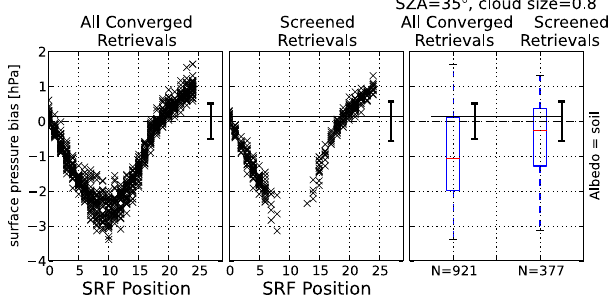
Figure 13. Summary of surface pressure and X retrieval bias CO 2 and covariance for all scenarios with 0.6 and 0.8 km clouds. Plot panels are arranged in the same order as Fig. 8. In each panel, the screened retrievals are shown (black points) along with the mean clear sky retrieval (large cyan cross). The ellipse shows the 1 σ pos- terior covariance for these two retrieved variables, offset by an ar- bitrary amount for display clarity.